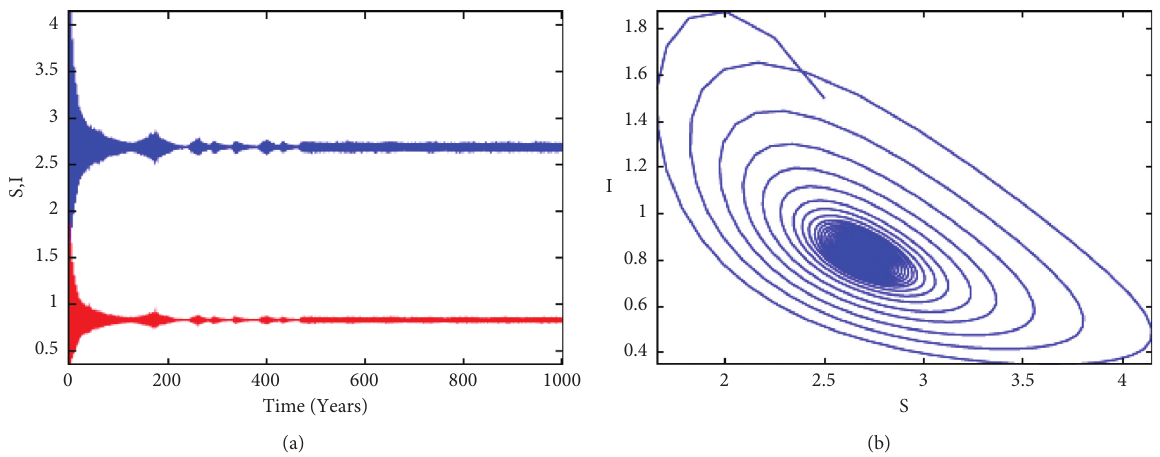
Figure 5: Phase trajectory for model system (4). The solution approaches periodic orbit around endemic equilibrium when R diagram of S , I - plane. (b) Phase diagram of E , I -plane.